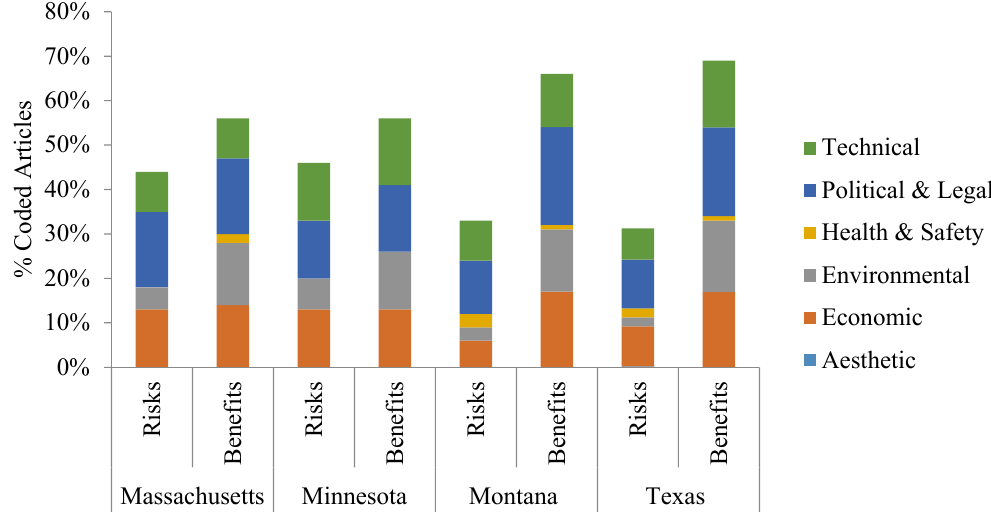
Figure 1. Media coverage of CCS function systems and their related risks and